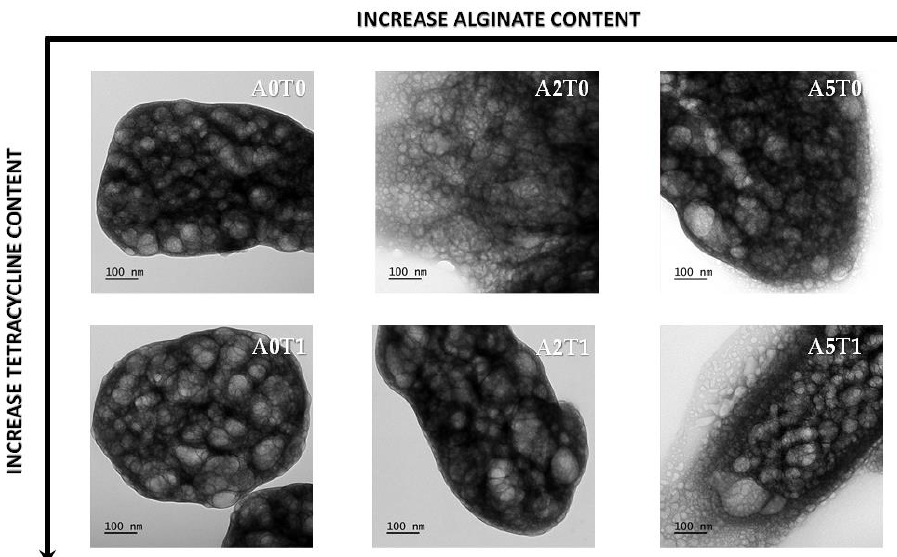
Figure 3. TEM micrographs of all samples at the same magnification.